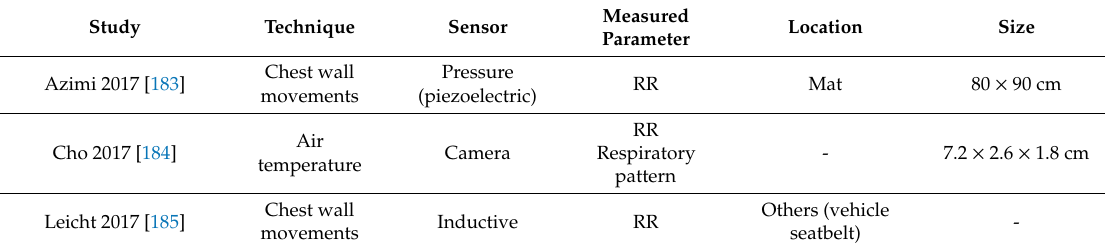
Table A2. Analysis of sensing techniques, sensors, breathing parameters, and sensor location and size for studies of the environmental category published before